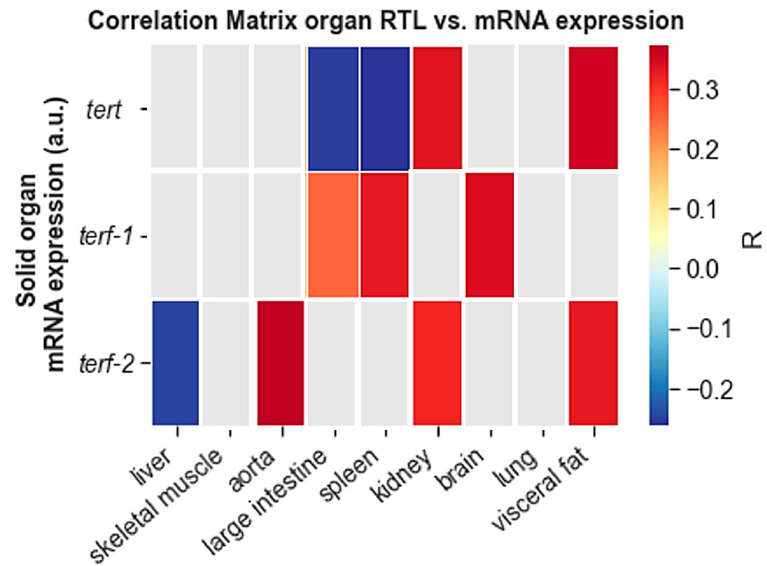
Figure 8. Correlation matrix for RTL and telomere-regulating genes in 9 solid tissue types. The colour bar on the right side of the figure shows the Pearson correlation coefficient as R. Only significant correlations are shown in colour ( p ≤ 0.05). Grey boxes indicate the lack of significant correlation.